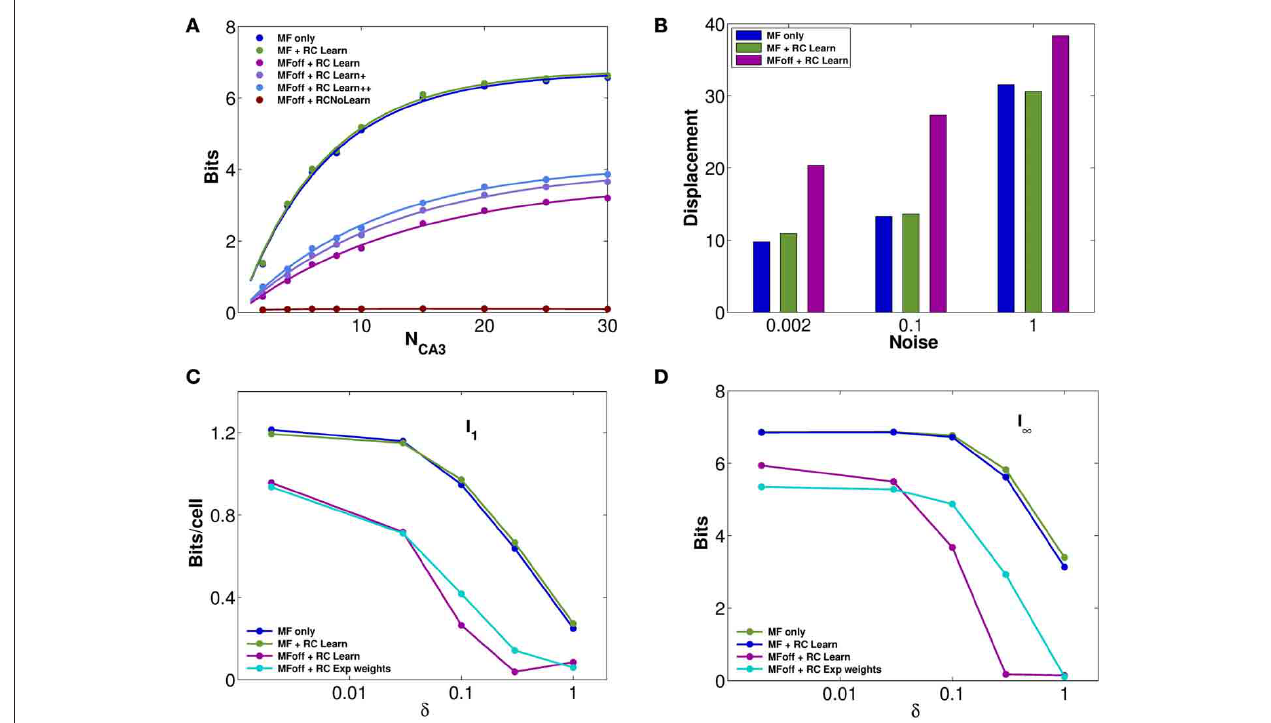
FIGURE 3 | Recurrent collaterals contribute little to the code, but sustain it, in part. (A) Information plotted versus the number of CA3 units in the sample. Fast noise δ = 0 . 1. Blue curves refer to the DG-CA3 system without recurrent collaterals; adding the recurrent collaterals leads to the light green curves, and to the purple-light blue curves when mossy fiber inputs are turned off. The three purple to light blue curves refer to networks with DG inputs turned off, and recurrent connections self-organized with progressively more intense training, from bottom to top: simulations with 10,000 learning time steps and γ = 0 . 0001; with 10,000 training steps but γ = 0 . 002; and with γ = 0 . 002 but 20 × 10,000 training steps. The dark green curve (nearly flat) shows the spatial information present in the system when DG inputs are off, in the